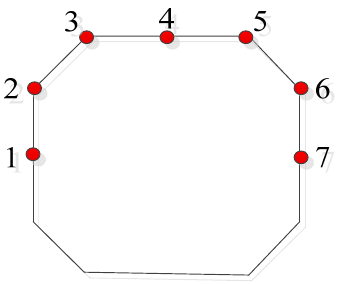
Figure 24. The specific measurement points of the transformer winding vibration test.